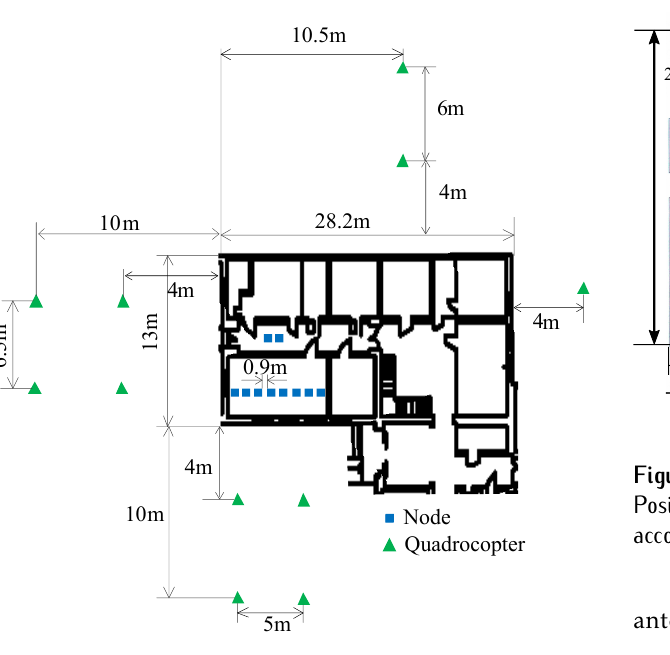
Figure 1. Floorplan of the Helmholtzbau building. The locations of the QC and the nodes are marked accordingly.